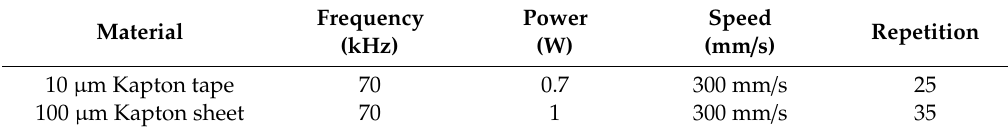
Table 2. Laser parameters used for ablating the